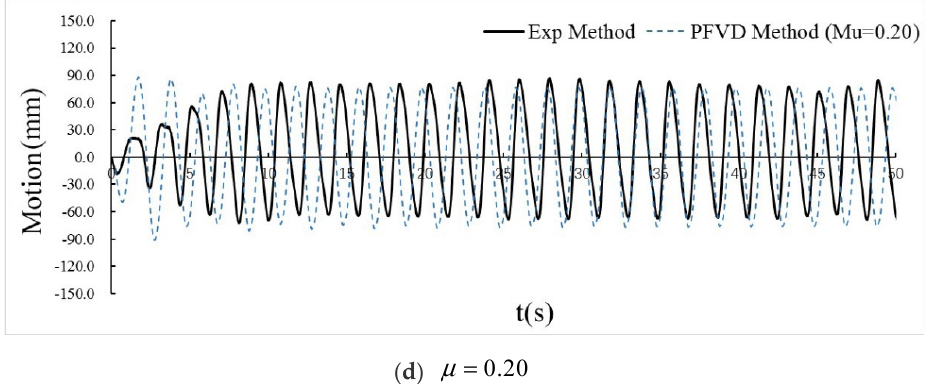
Figure 19. Motion response of MJWEC with different dissipation correction factors over time.